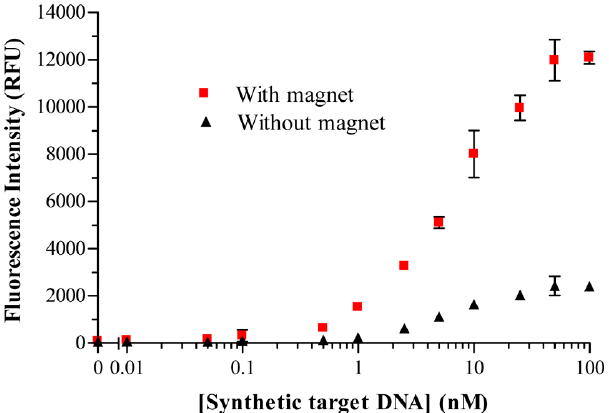
Figure 10. Sensitivity and limit of detection (LOD) enhancement in the presence (squares) versus absence (triangles) of a magnet. Figure reprinted with permission from [65]. Copyright 2014 American Chemical Society.